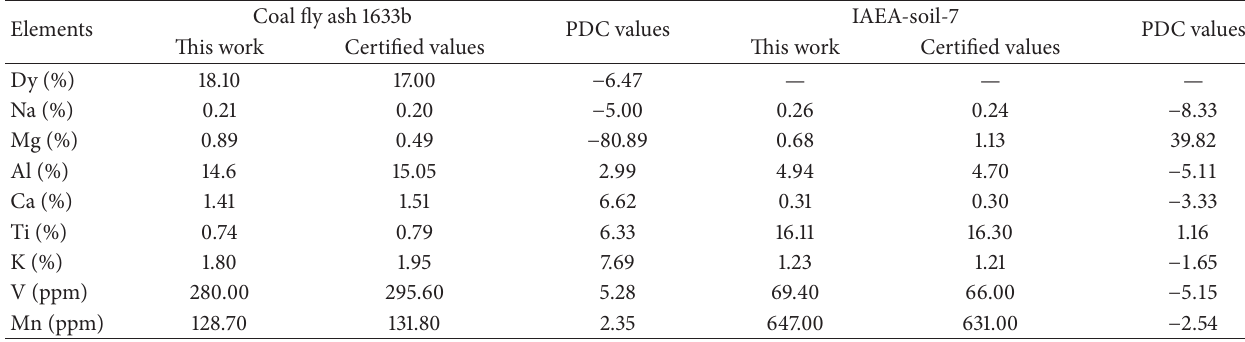
Table 4: Quality control data for coal fly ash 1633b (NIST) and IAEA-soil-7 reference